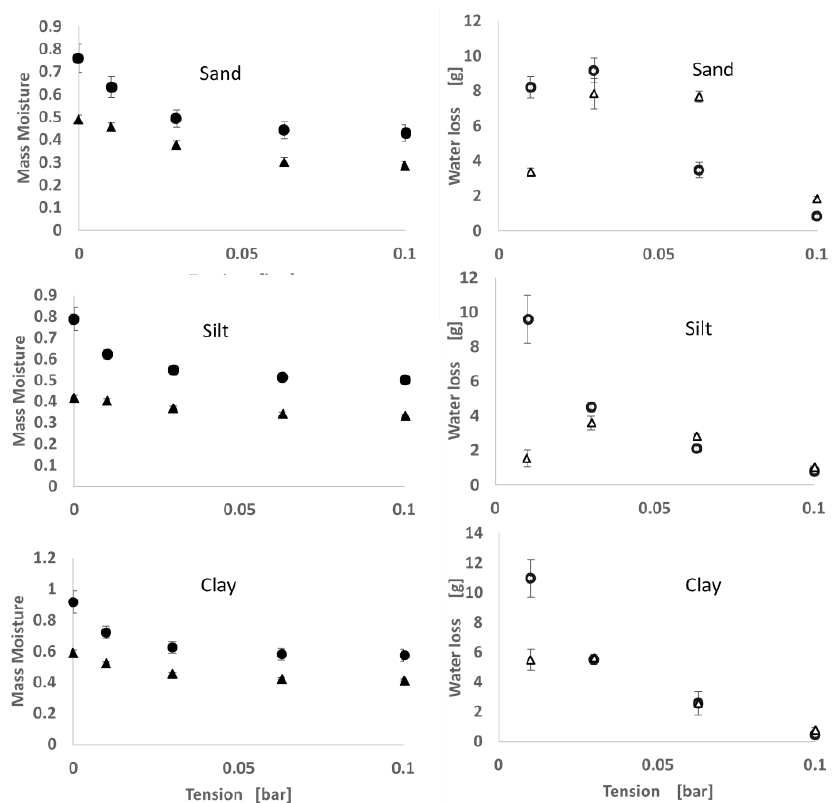
Figure 2. Mass moisture and water loss as a function of tension for CAST (circles) and NOCAST (triangles) soils. Error bars represent 1 standard error.